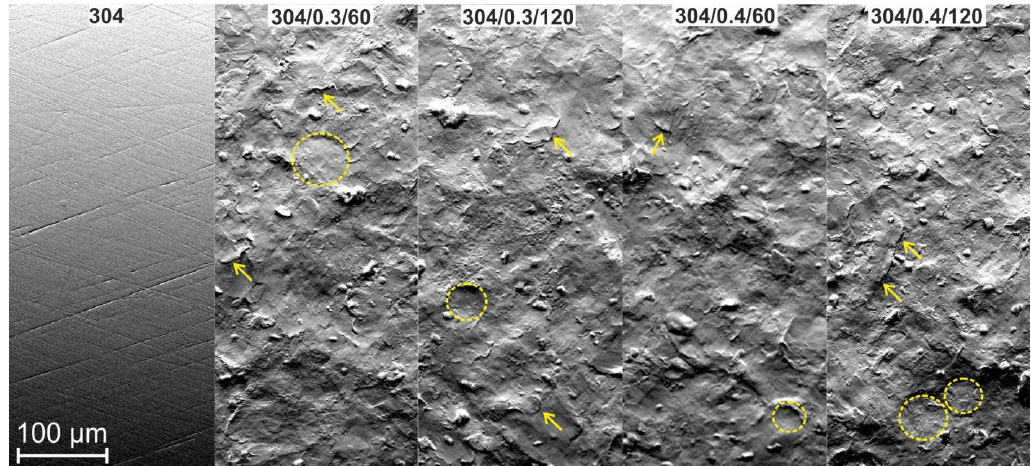
Figure 3. The morphology of specimens surfaces before (sample 304) and after peening with different parameters. Rings indicate spherical CrNi shot bowl imprints; arrows mark overlapping dent, SEM.